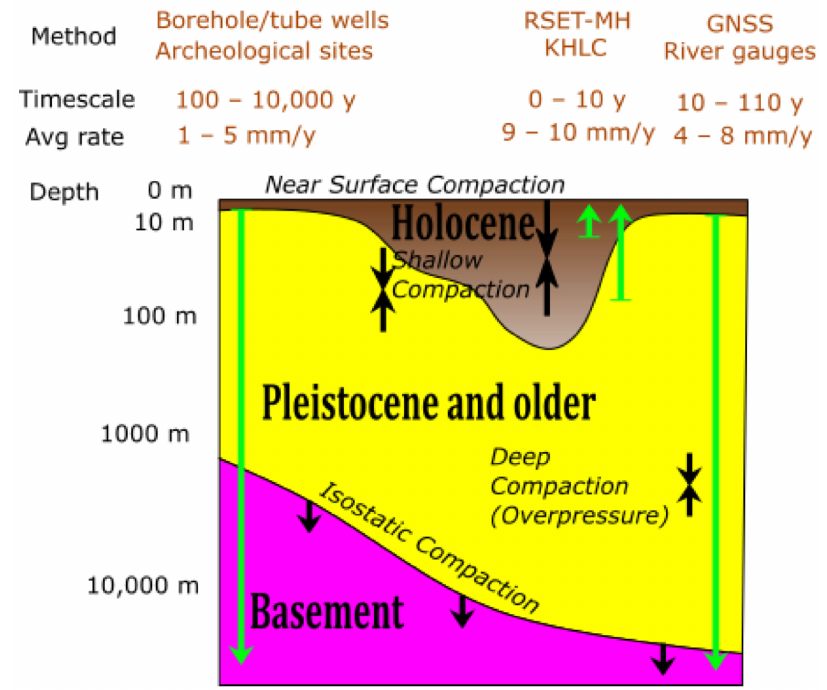
Figure 9. Illustration of subsidence measurements in the GBM Delta (Source: subsidence and compaction dimensions retrieved from Steckler et al., 2022)